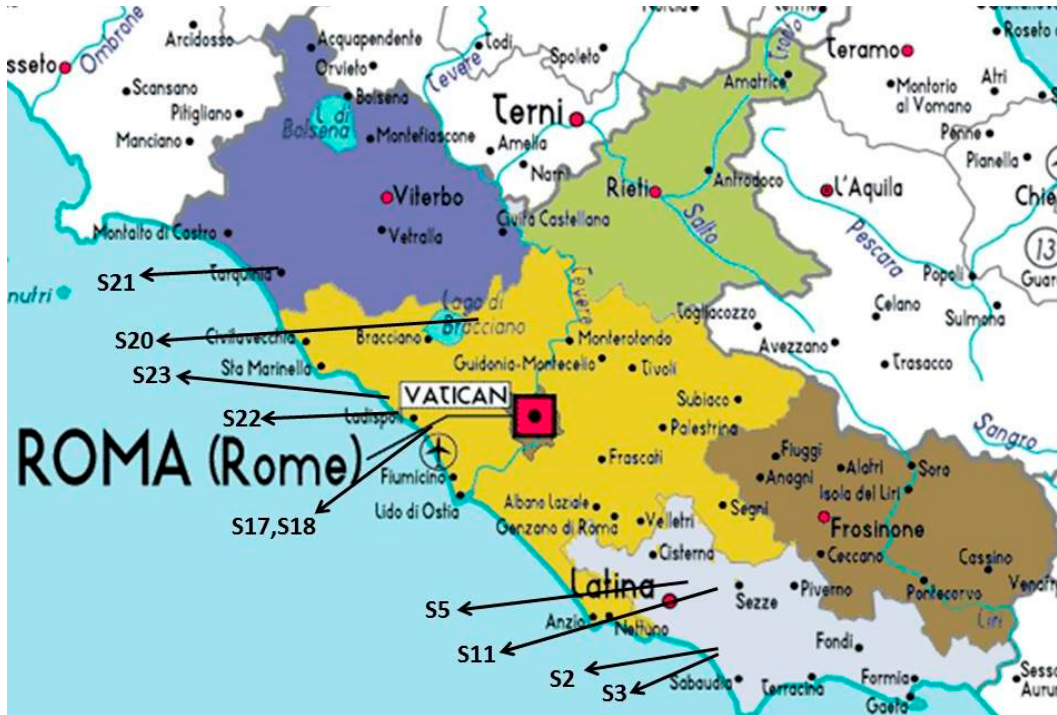
Figure 1. Geographic location of the analyzed clones.